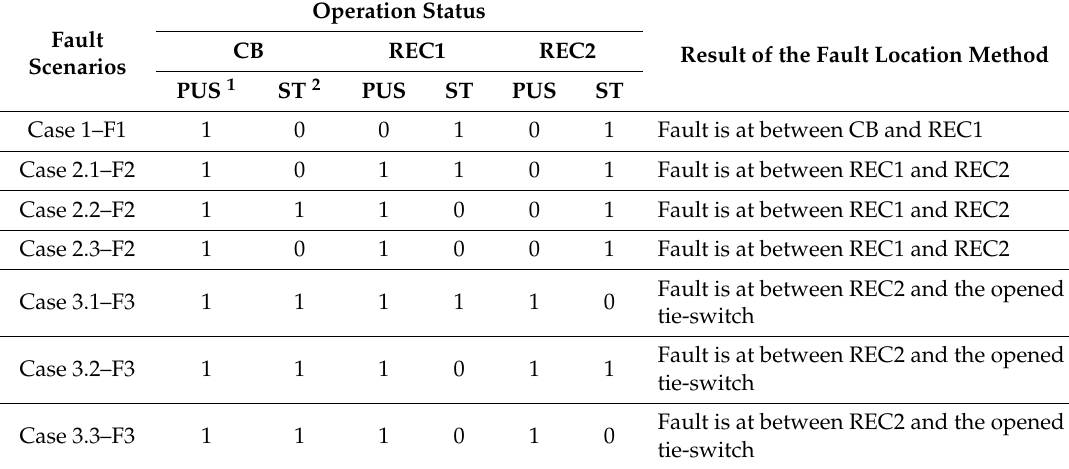
Table 3. The fault location method using the PUS with respect to different fault scenarios.